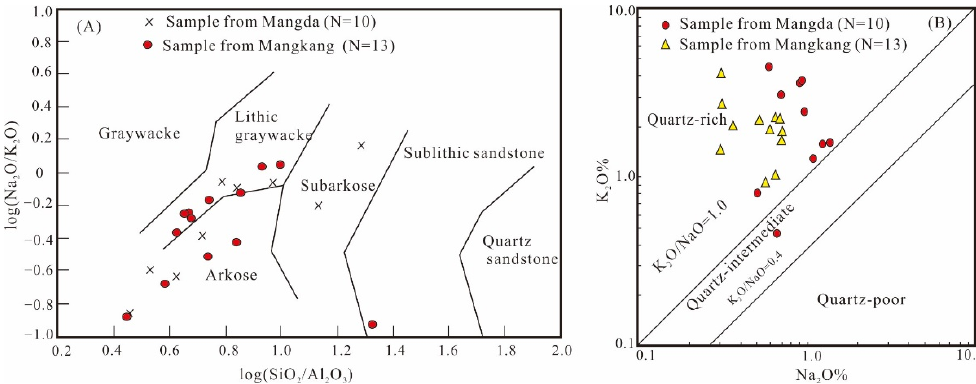
Figure 3. Geochemistry classification diagrams of sandstones of the Jinxing Formation in Qamdo basin ( A , after Pettijohn et al., 1972 [47]; B , after Asiedu et al., 2000 [48]).